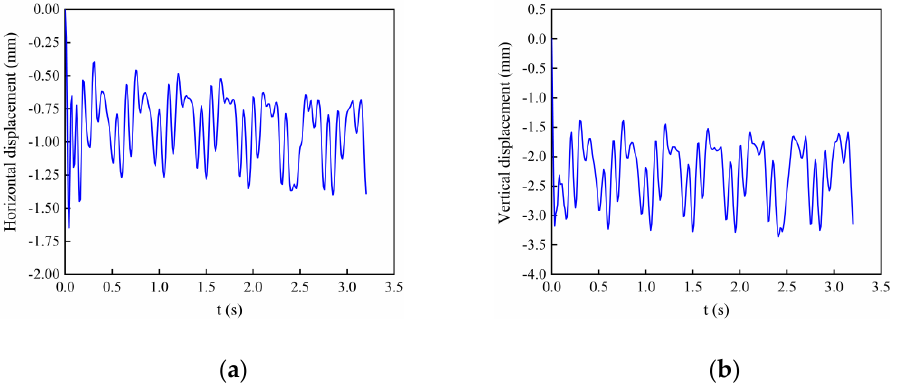
Figure 14. Displacement response of middle partition wall measuring point: ( a ) horizontal displace- ment response of C3 during single-train traffic; ( b ) vertical displacement response of C5 during double-train traffic.